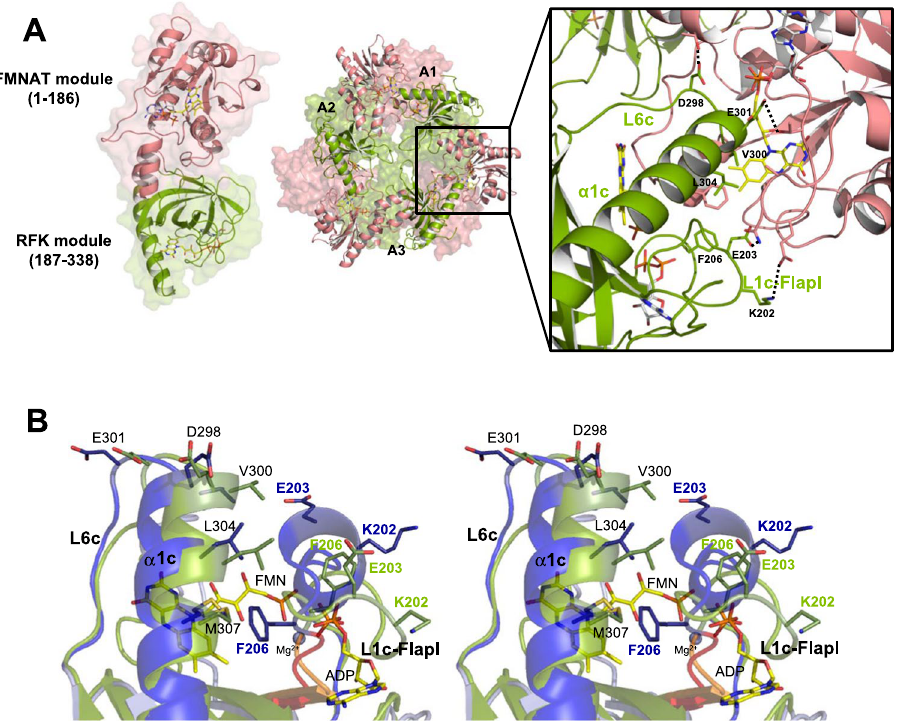
Figure 1. Structure of Ca FADS. ( A ) Cartoon representation of the Ca FADS monomer (PDB code: 2x0k) and of the dimer of trimers model predicted by the PISA server (one of the trimers is represented as a surface). The RFK module and the FMNAT module are colored in green and pink, respectively. The right panel shows a detail of the head-to-tail disposition between the RFK and FMNAT modules of neighboring protomers, within each one of the trimers. Residues involved in the stabilization of the trimer are shown as sticks and the ones mutated in the present work are labelled. H-bonds and salt-bridges established by these residues are indicated with dotted lines. Predicted positions for flavin and adenine nucleotide ligands are shown as sticks with carbons in yellow and gray, respectively. ( B ) Cross-eye stereo view of the superposition of the RFK modules of Ca FADS (PDB code: 2x0k; green) and the ternary complex Ca FADS RFK:FMN:ADP:Mg 2 + (PDB code: 5a89; blue). Relevant residues are shown in sticks. FMN, ADP (in sticks CPK colored with C in yellow) and Mg 2 + (blue sphere) are from the ternary complex structure. Backbones of the PTAN motifs (207–210 residues) of Ca FADS and the ternary complex are highlighted in orange and red,